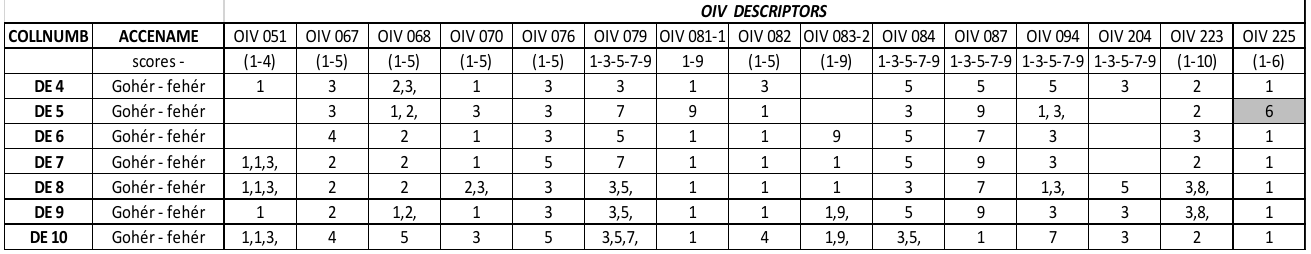
Table 5: OIV codes OIV Code N° Descriptor precise SSR-marker based identification must simultaneously be